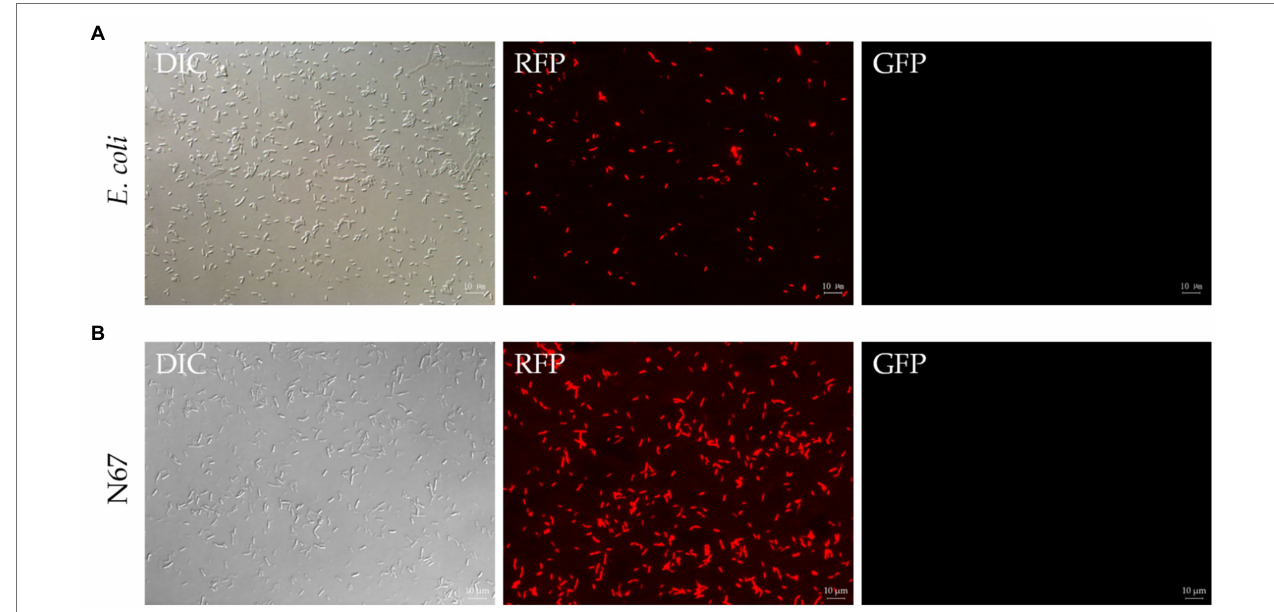
FIGURE 2 | Fluorescence observation of Escherichia coli and N67 under microscopy. DIC, differential interference contrast field; RFP, red fluorescence field; and GFP, green fluorescence field. (A) Representative fluorescent micrograph of E. coli under fluorescent microscope. Heat-shock transformation was used to transform pYP69 into E. coli DH5 α competent cells. The positive transformants on the solid medium containing 100 μ g/ml ampicillin/ could be observed under the microscope. (B) Representative fluorescent micrograph of N67 under fluorescent microscope. Electric-transformation was used to transform pYP69 into N67 competent cells. The positive transformants on the solid medium containing 10 μ g/ml chloramphenicol could be observed under the microscope. Scale bar: 10 μ m.